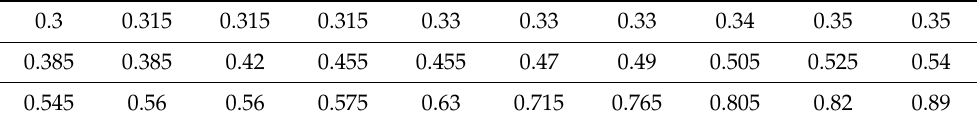
Table 6. The optimal ( m *, t *, n *), total cost TC and critical value C 0